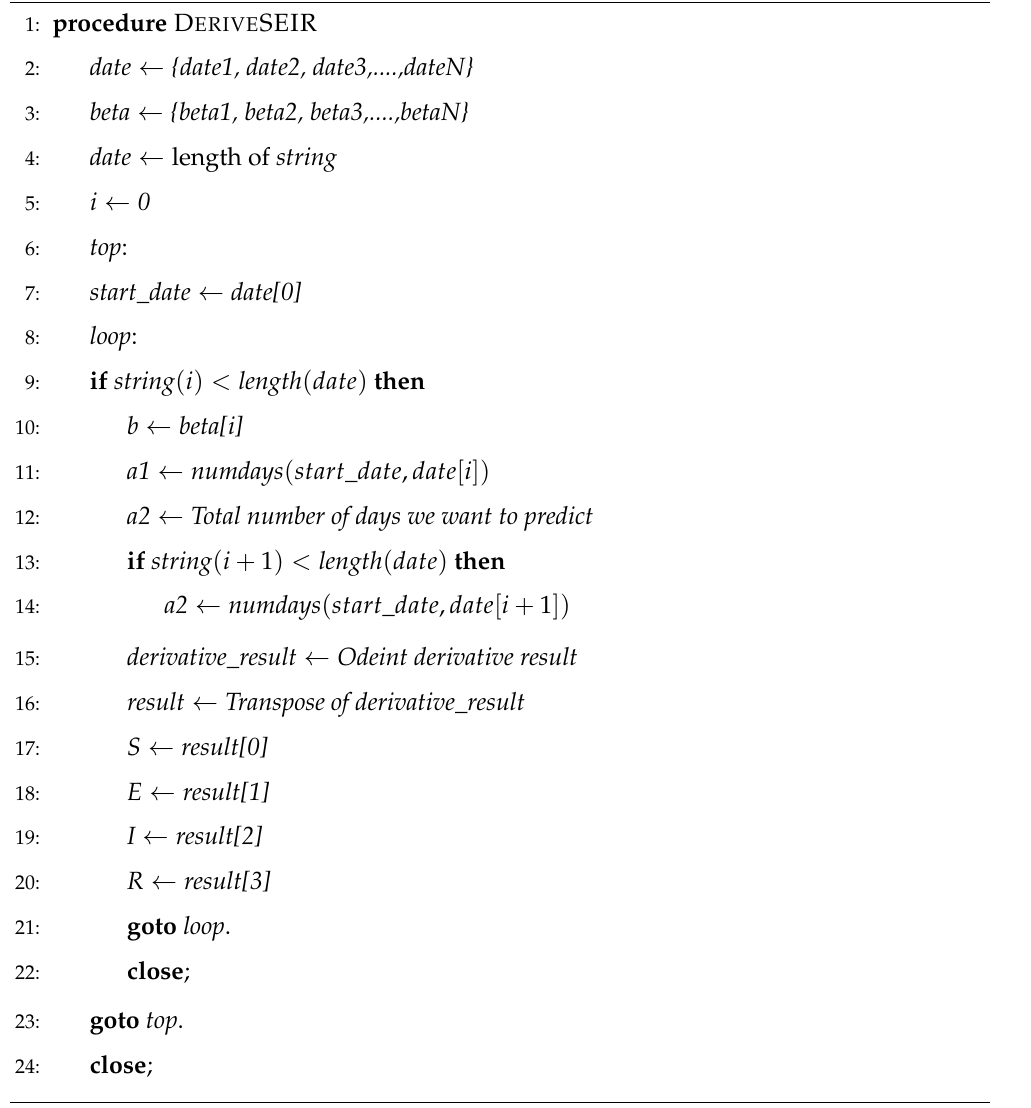
Algorithm 1 Calculation process of the SEIR differential